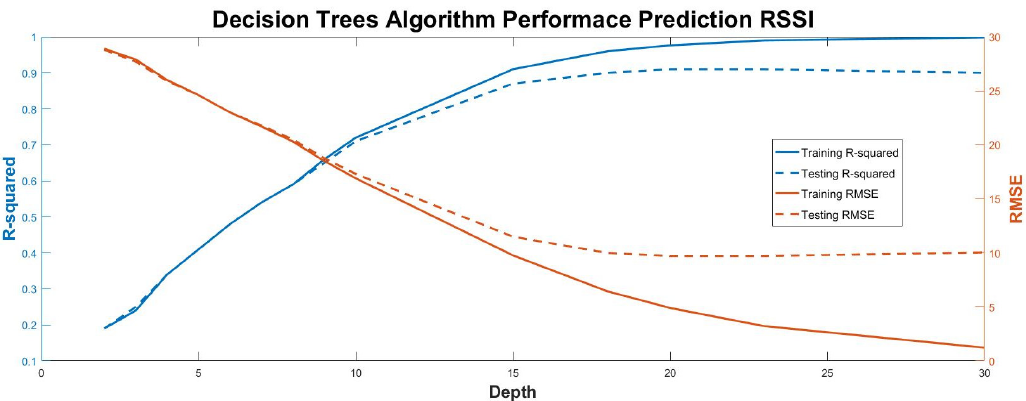
Figure 7. Performance metrics plot for decision tree algorithm against different number of neighbors.